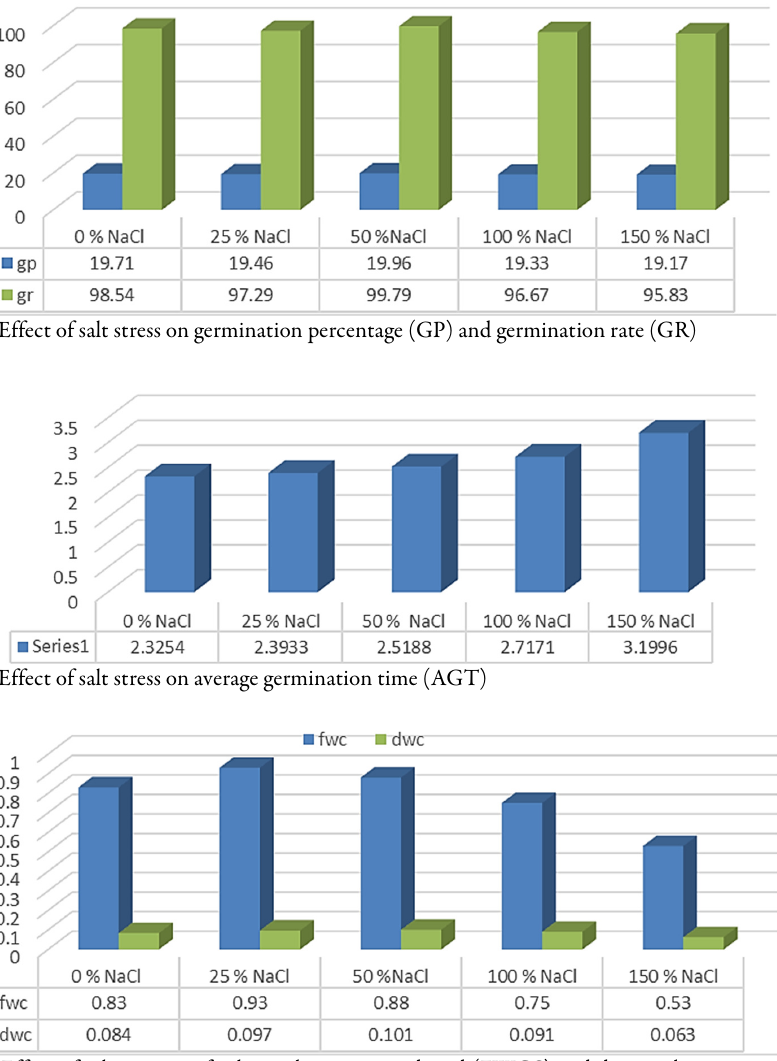
Figure 5. Effect of salt stress on fresh weight germinated seed (FWGS) and dry weight germinated seed